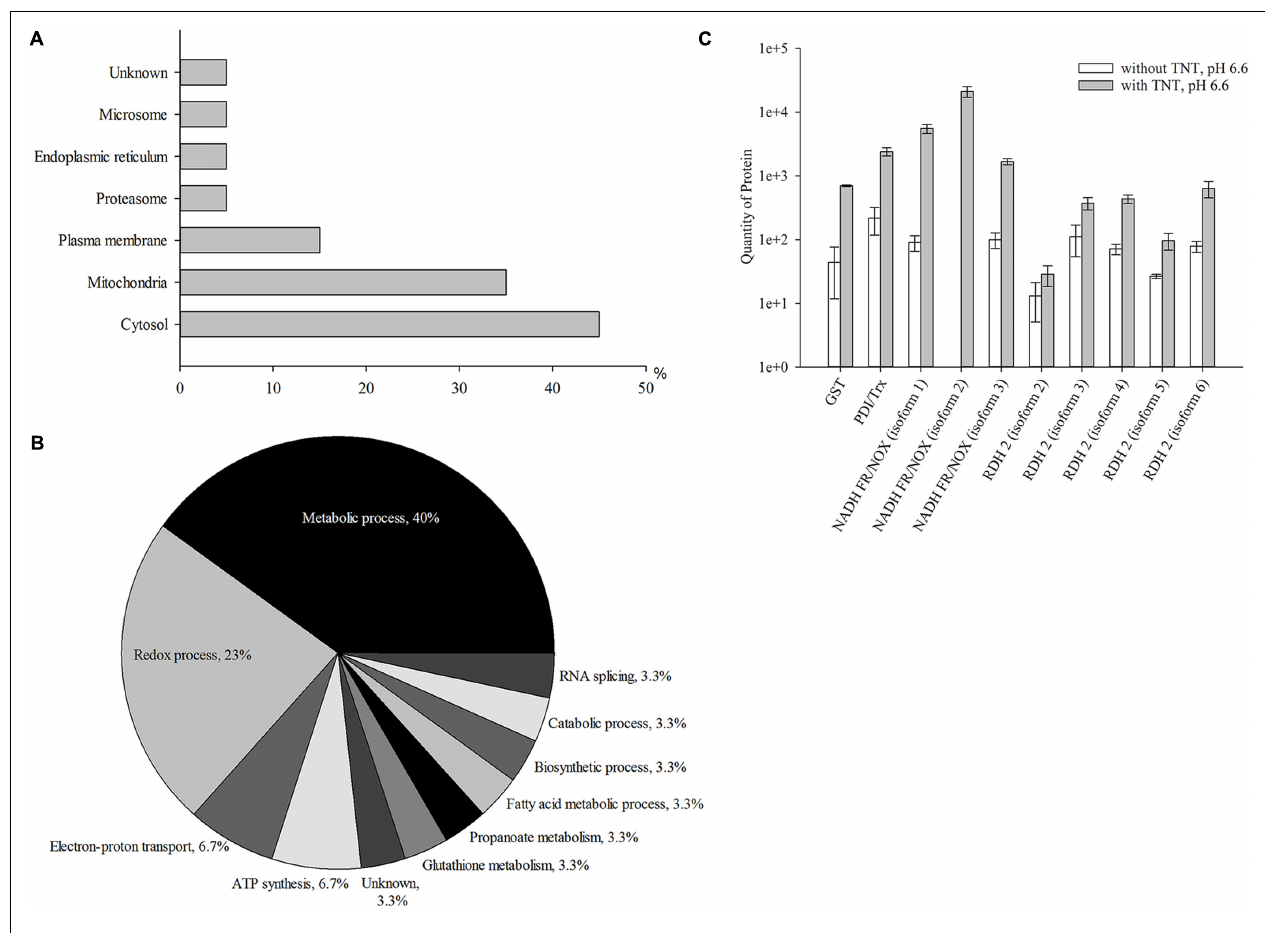
FIGURE 1 | Up-regulated proteins at the first stage of TNT transformation by Yarrowia lipolytica : their intracellular localization (A) ; participation in metabolic processes (B) and the quantity of major proteins maximal up-regulated by TNT (C) . (A,B) For 100% all identified proteins at the first stage of TNT transformation were taken. (C) Error bars represent the standard deviation of duplicate biological experiments with two technical repetitions. GST, glutathione S- transferase; PDI/Trx, protein disulfide isomerase/thioredoxin; NADH FR/NOX, NADH flavin oxidoreductases/NADH oxidases; RDH, retinal dehydrogenase